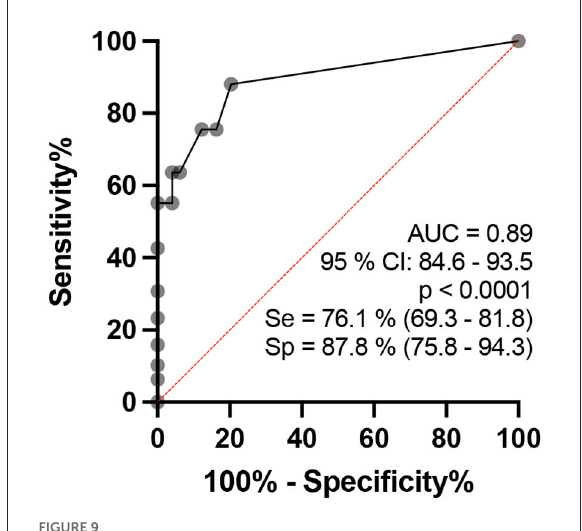
FIGURE11 ROC curve analysis of the percentage of the number of altered 1 TpT ( > 2.5 mm 2 - focality) of the neural sites assessed per individual when comparing the healthy and leprosy groups in the age range of 15–60